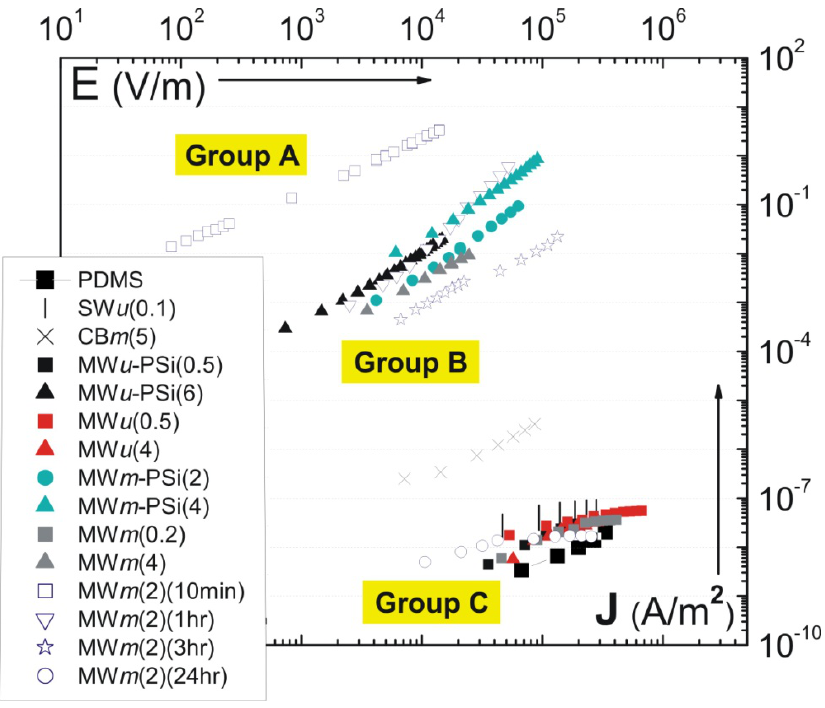
Figure 7. Master plot of current density vs. applied field J-E for a range of carbon polymer